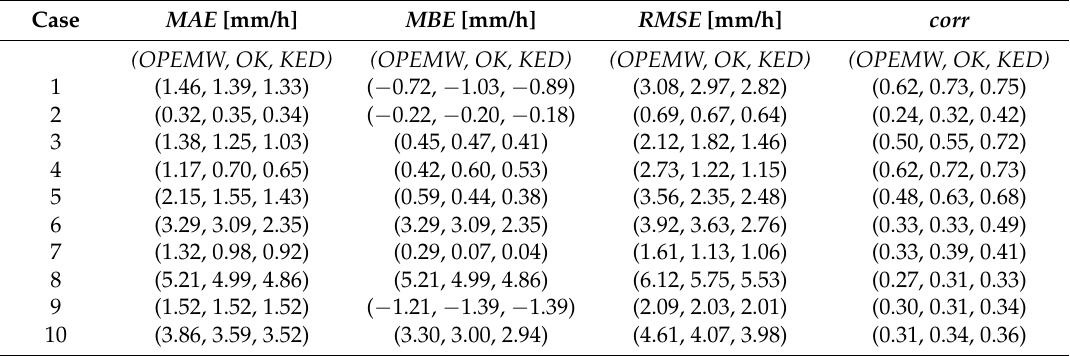
Table 2. Continuous statistics against rain gauge observations for original OPEMW data, and data